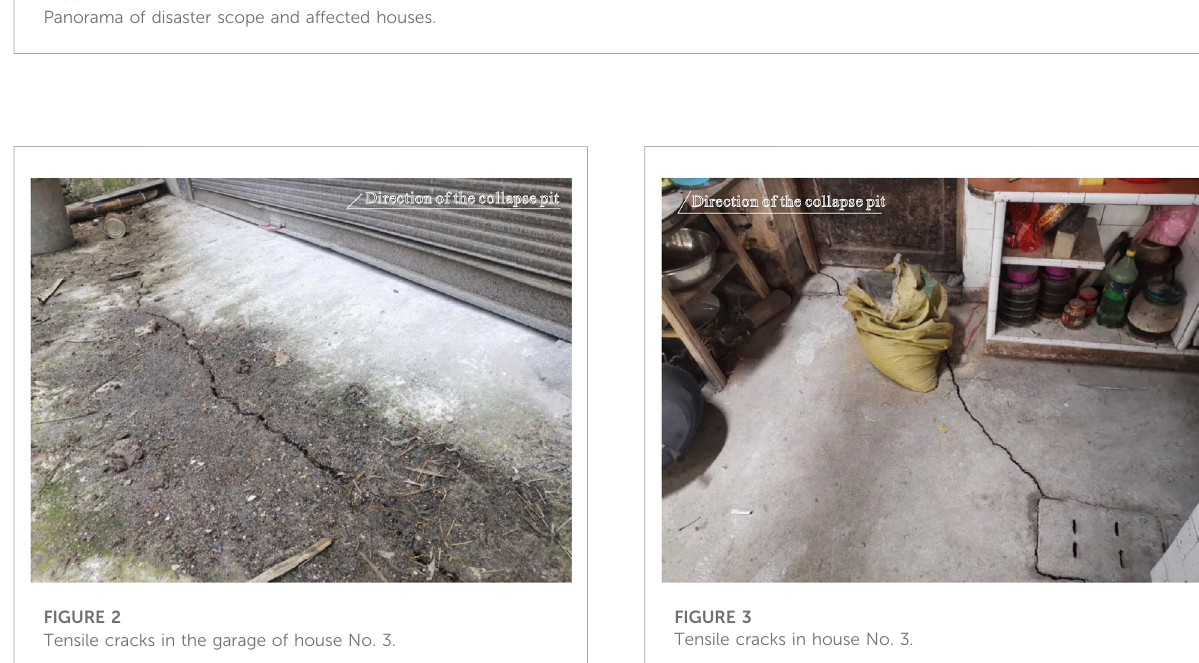
FIGURE 1 Panorama of disaster scope and affected houses.